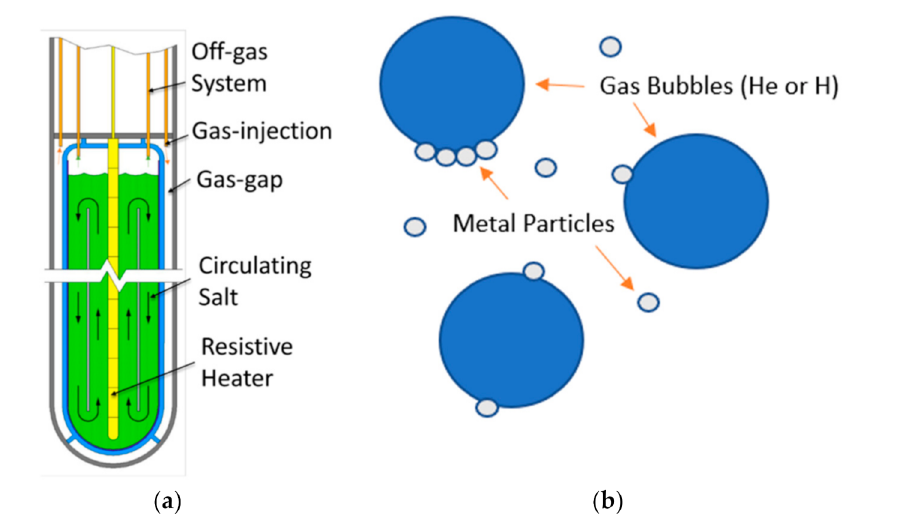
Figure 1. ( a ) Preliminary VESIL Design—Reproduced with permission from [1] Abou-Jaoude, A.; Palmer, J.; Sterbentz, J.; Calderoni, P. Evaluation of a Versatile Experimental Salt Irradiation Loop (VESIL) inside the Advanced Test Reactor. In INL/EXT-19-52917 ; Idaho National Laboratory: Idaho Falls, ID, USA, 2019; ( b ) Noble Metal Flotation via